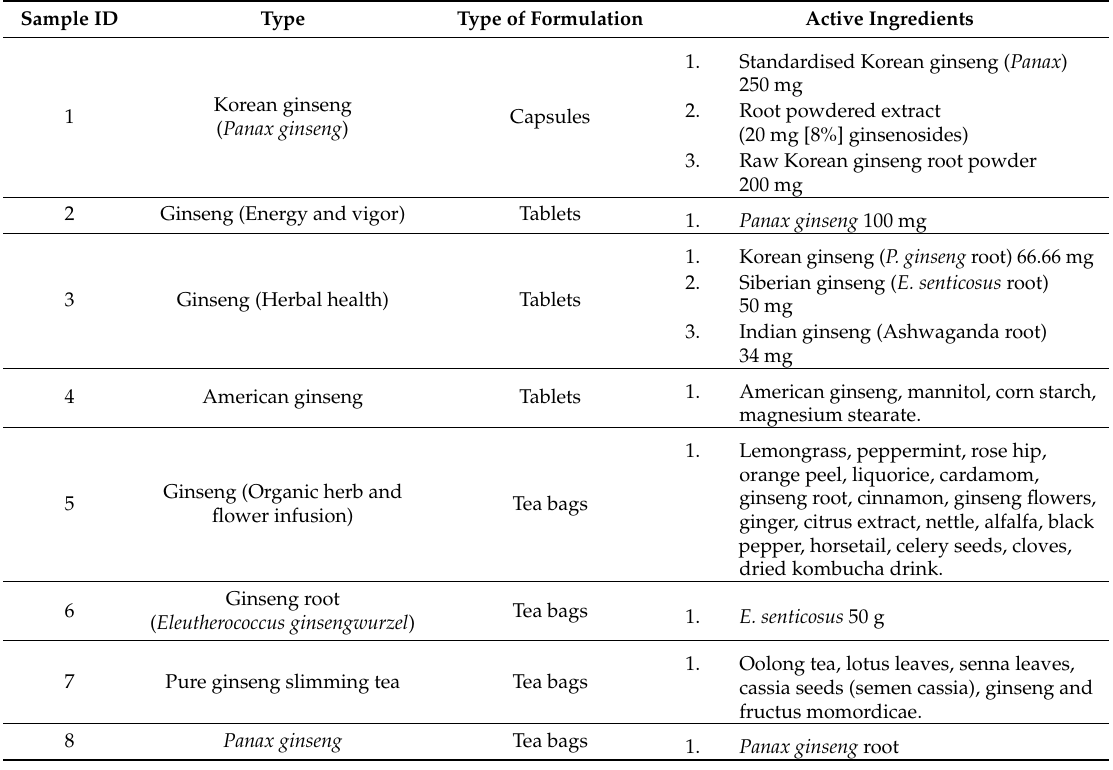
Table 6. Formulation and labelling information for the commercial ginseng products